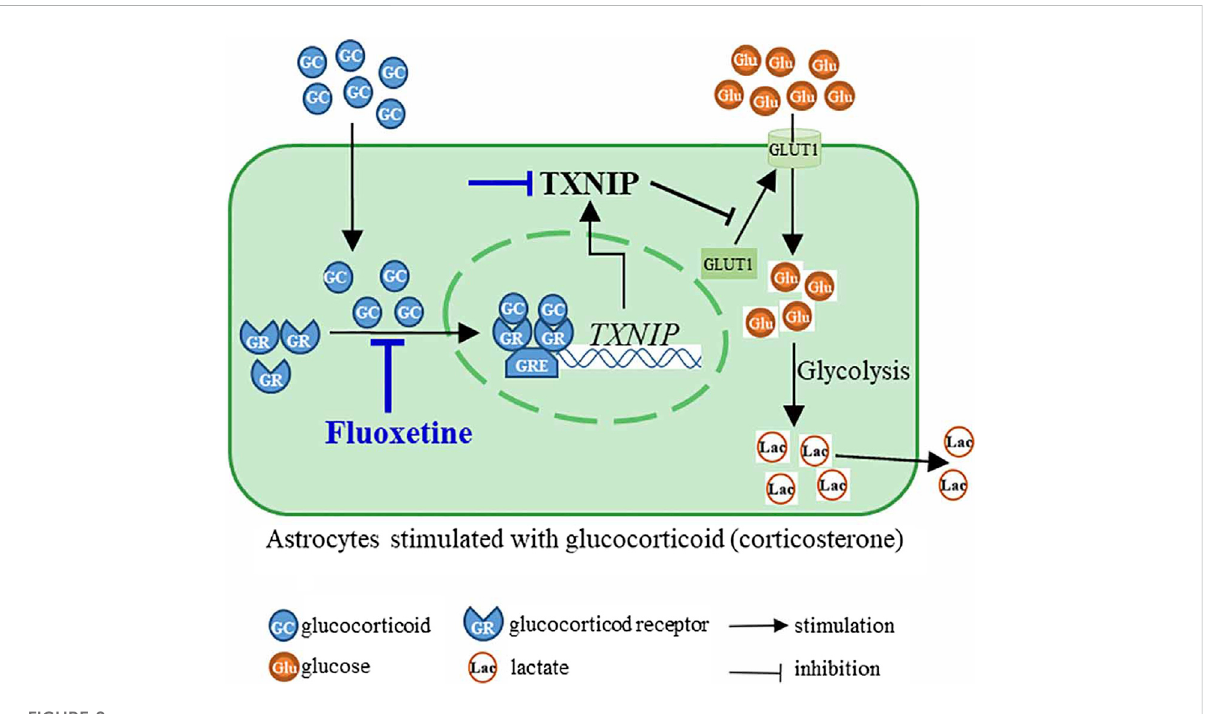
FIGURE 8 Fluoxetine inhibited nuclear translocation of glucocorticoid receptor (GR) to suppress the transcription of TXNIP , and then modulated TXNIP- GLUT1 pathway, resulting in the improvement of astrocyte glucose uptake and glycolysis in corticosterone-induced